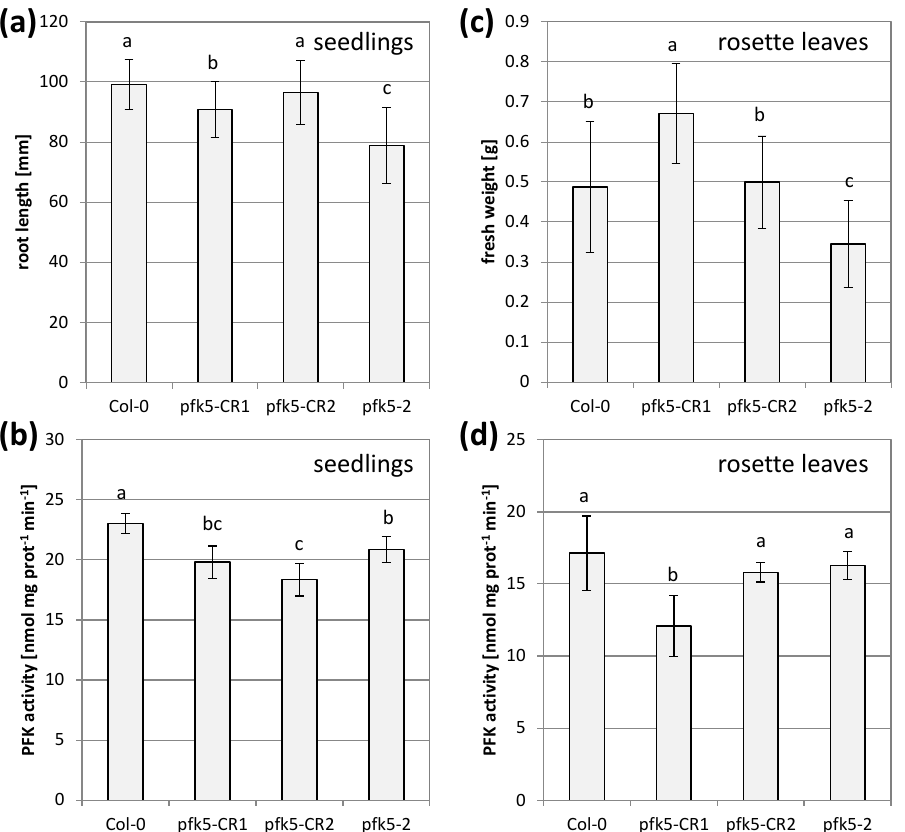
Figure 9. Analysis of two independent PFK5 CRISPR lines. ( a ) A. thaliana seedlings of pfk5-CR1 and pfk5-CR2 were grown under long-day conditions on solid 1/10 Hoagland medium together with pfk5-2 and the wildtype Col-0. After 14 days, root length was determined. Data represent means ± SD of 3 independent experiments with 20 individuals each. Letters indicate significant differences at p < 0.05 (ANOVA, Post hoc Tukey test). ( b ) PFK activity of 7-day-old seedlings of the four genotypes grown on MS medium. Different letters indicate significant differences in protein activity at p < 0.05 (ANOVA, Post hoc Tukey test, n = 5–6). ( c ) Rosette weight of 5-week-old plants of the four genotypes grown on soil. Data are means ± SD of 12 plants. Letters indicate significant differences at p < 0.05 (ANOVA, Post hoc Tukey test). Images of the plants are shown in Supplementary Figure S5. ( d ) PFK activity in crude leaf extracts from 5-week-old rosette leaves of the four genotypes. Data are means ± SD. Letters indicate significant differences among genotypes at p < 0.05 (ANOVA, Post hoc Tukey test, n = 4).